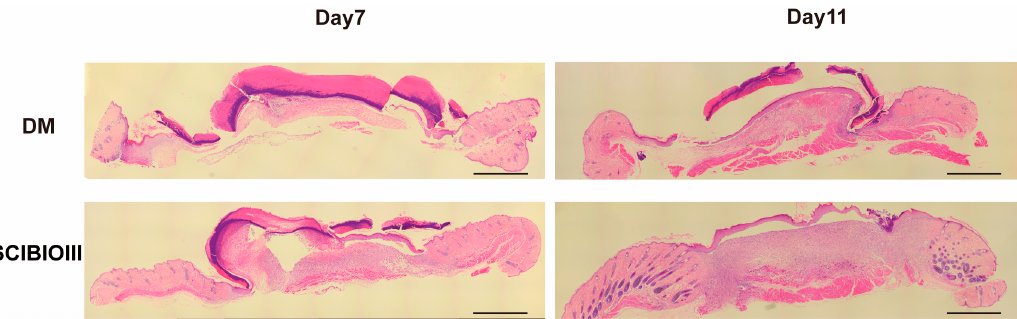
Figure 6. SCIBIOIII hydrogel advanced the formation of granulation tissue in diabetic mice with skin wounds. Representative pictures on days 7 and 11 ( n = 5). Scale bar: 1.5 mm.